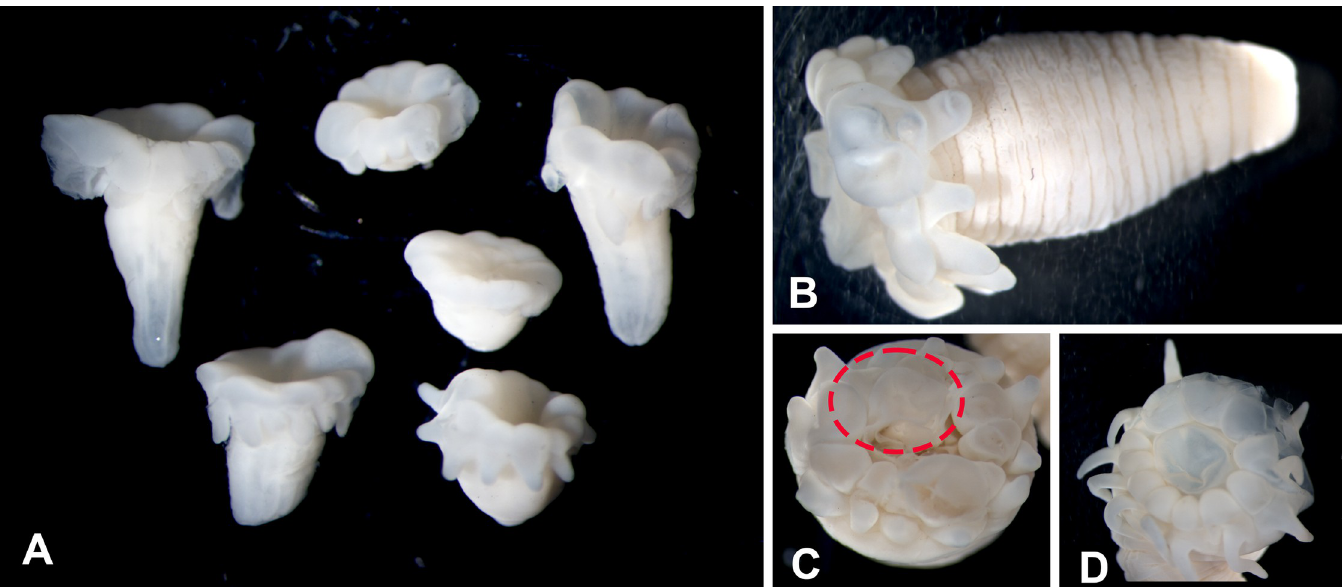
Fig 4. External anatomy of Peachia chilensis . (A) Lateral view of six of the smaller specimens of P . chilensis , showing the diversity in developmental stages in the smallest of the specimens. (B) Lateral view of larger specimen showing the lack of visible capitulum, scapus, or physa. (C) Dorsal view of specimen showing the protruding conchula (circled in red). (D) Dorsal view of specimen, showing esophageal folds.